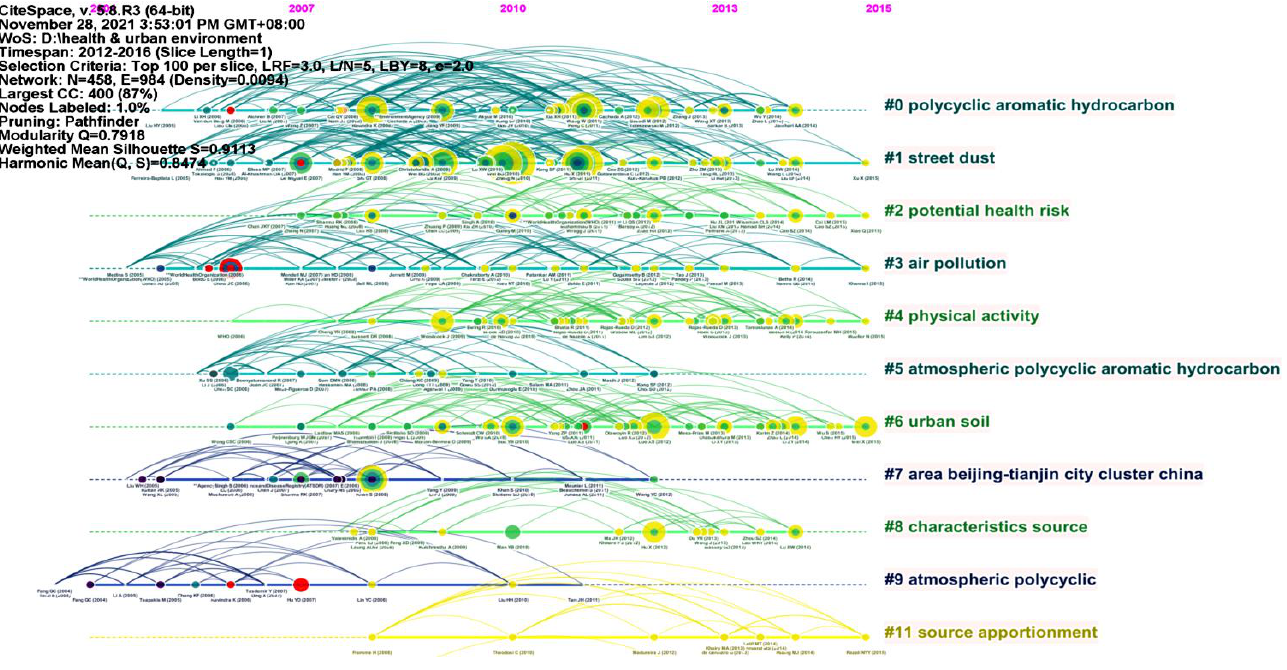
Figure 8. A timeline visualization of clusters on urban HIA research in 2012–2016.